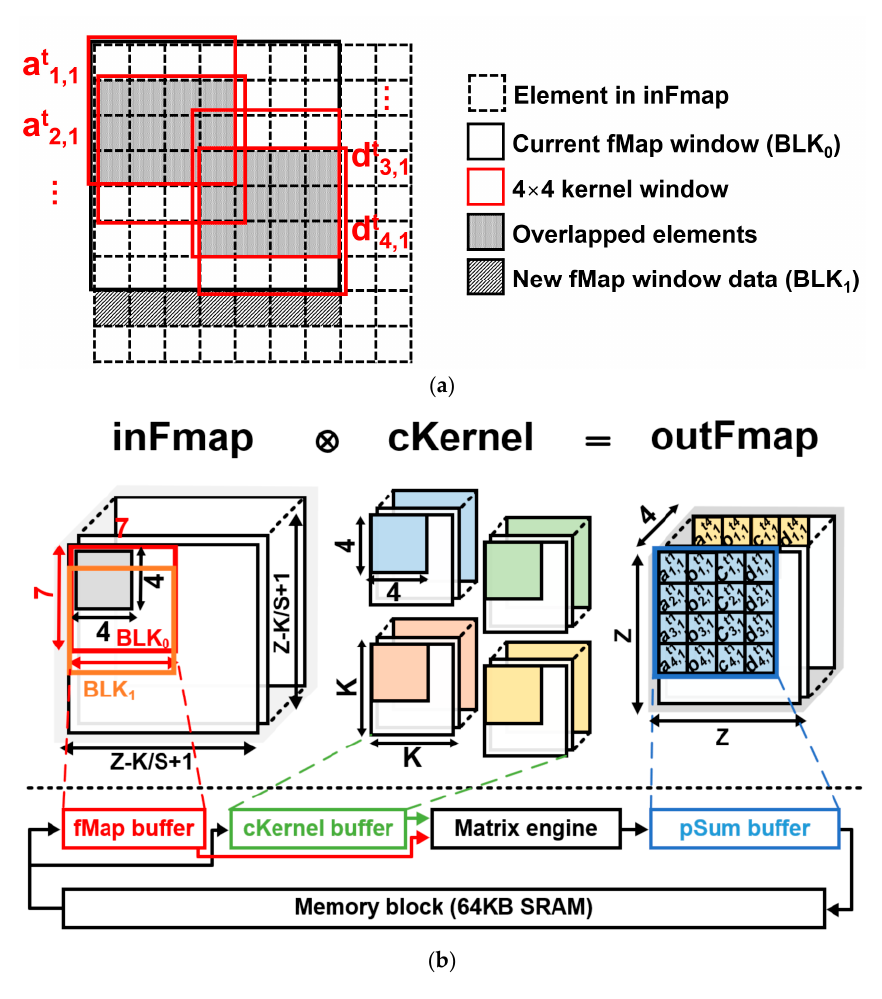
Figure 9. Tiling-based data reuse in CENNA: ( a ) example of overlapped elements in adjacent windows; ( b ) data tiling and memory hierarchy used for CENNA.